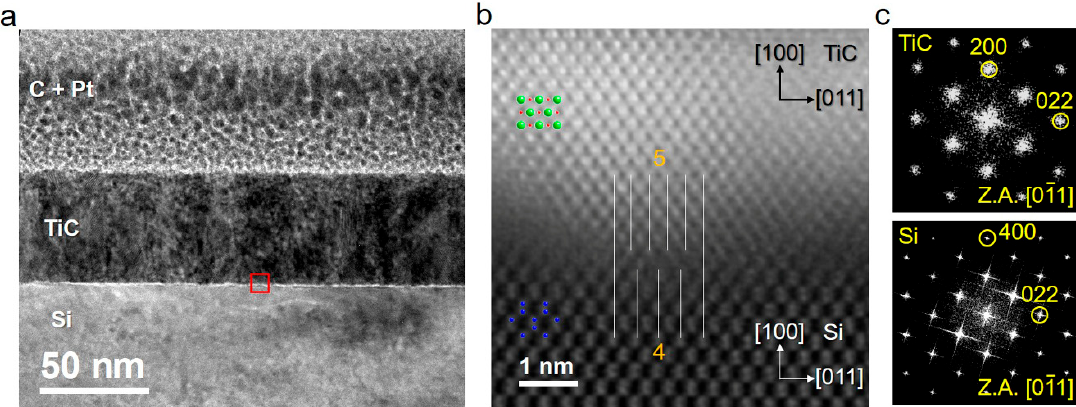
Figure 10. ( a ) Cross-sectional BF TEM image of the TiC layer on Si for the 5% CH 4 / 6 min sample; ( b ) Atomic resolution scanning transmission electron microscopy (STEM)-ADF image of the TiC / Si interface (the red box in Figure 10a) (after Wiener filtering) showing Z-contrast. Bright and gray dots correspond to Ti and Si atomic columns, respectively. Projected atomic configurations of TiC and Si structure models are shown in the image. The white lines illustrating the domain matching epitaxy (DME) relationship with 5 / 4 ratio. Zone axis // TiC [011] // Si [011]; and ( c ) fast Fourier transform (FFT) patterns of TiC and Si.